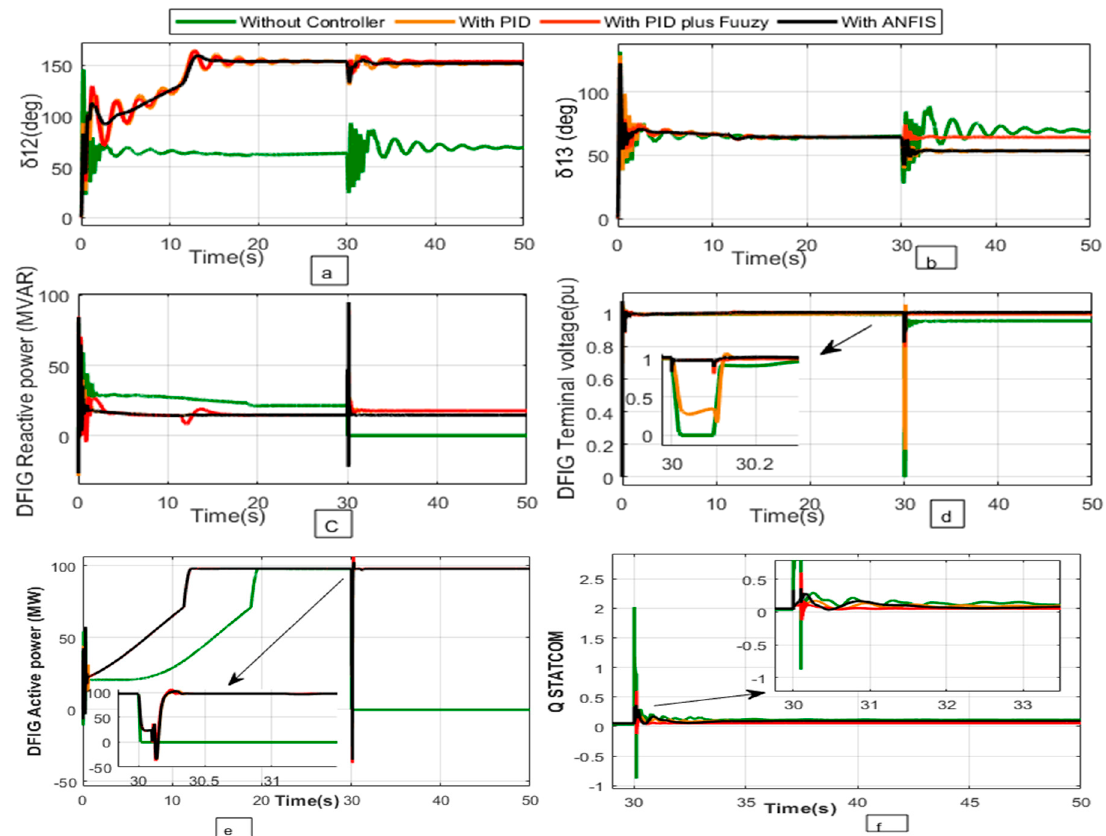
Figure 9. Studied system parameters during fault: ( a ) rotor angle deviation between SG1 and SG2; ( b ) rotor angle deviation between SG1 and SG3; ( c ) DFIG reactive power; ( d ) DFIG terminal voltage (output voltage); ( e ) DFIG active power; ( f ) STATCOM reactive power.